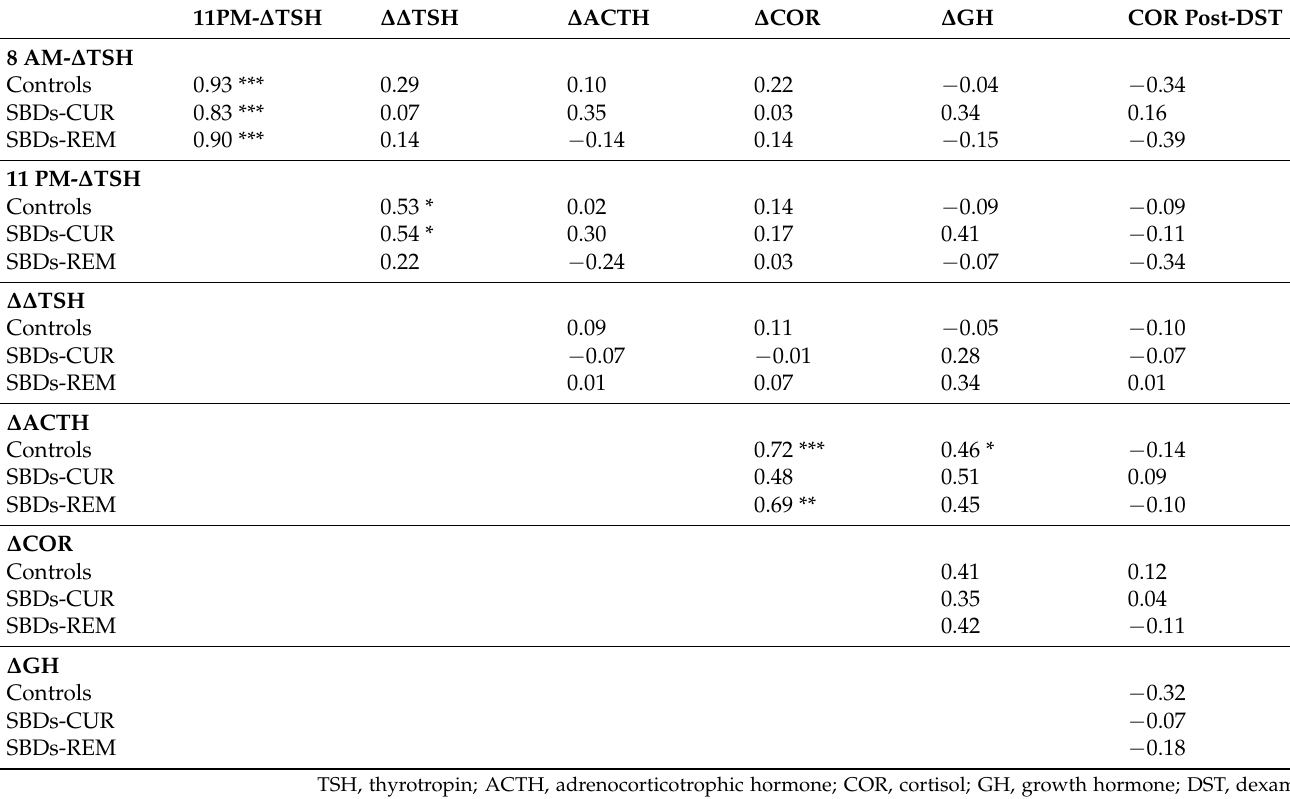
Table 3. Relationships among TRH, apomorphine and dexamethasone suppression tests in healthy controls and depressed patients with current (CUR) or in early remission (REM) suicidal behavior disorder